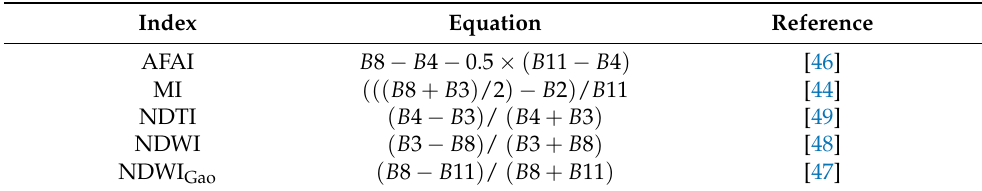
Table 2. Water-related indices formulated with Sentinel-2 spectral bands and used in this study.